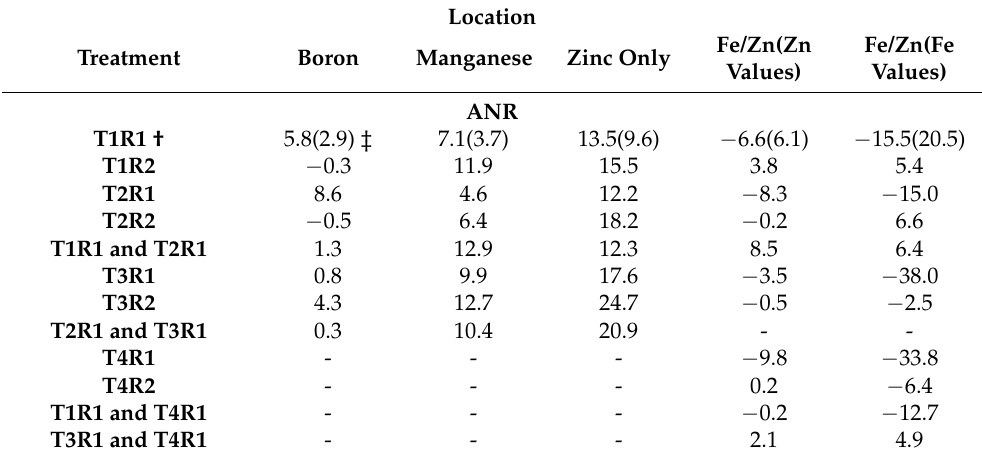
Table 6. LSMeans for Apparent Nutrient Recovery (ANR) at the end of the growing season (R6). Location Treatment Boron Manganese Zinc